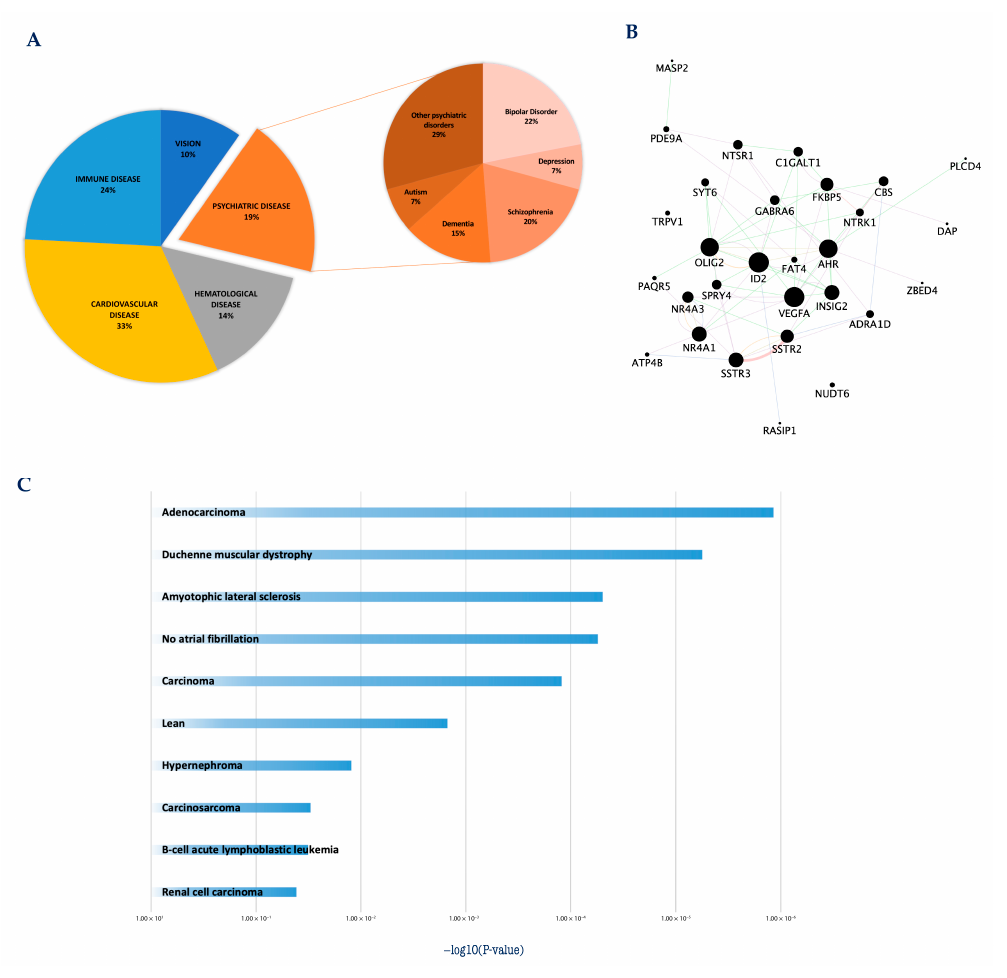
Figure 2. Core set genes are involved in the etio-pathogenesis of multiple cancer and neurological disorders. ( A ) Pie chart representation of core set genes implicated in human diseases. Disease enrichment analysis was performed with DAVID bioinformatics resources, including OMIM, KEGG DISEASE, and GAD catalogs. ( B ) The protein–protein interaction network of the 29 core set genes previously associated with cognitive/mental diseases. The network was built using the STRING website and visualized by Cytoscape (version: 3.8.2), by mapping the ‘degree parameter’ to node size. As the node size increased, the value of the connectivity degree of node genes increased. Differently colored ‘edges’ indicate the type of evidence supporting each interaction: dark purple: co-expression; light purple: physical interaction; light blue: co-localization; light green: shared protein domain; orange: predicted; grey: other. ( C ) Histogram of the most signi fi cantly enriched transcriptional signatures from iLINCS positively correlated with apoptotic CGN-related expression changes of core set genes. The signi fi cance of each disease related signature is represented by the enrichment scores value ( − log10 ( p -value)). For more details, please refer to the original work [44].